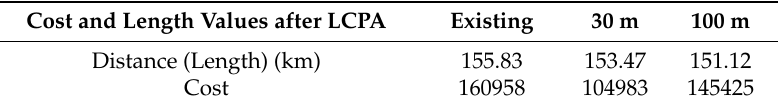
Table 3. Cost and length values after least cost path analysis (LCPA).